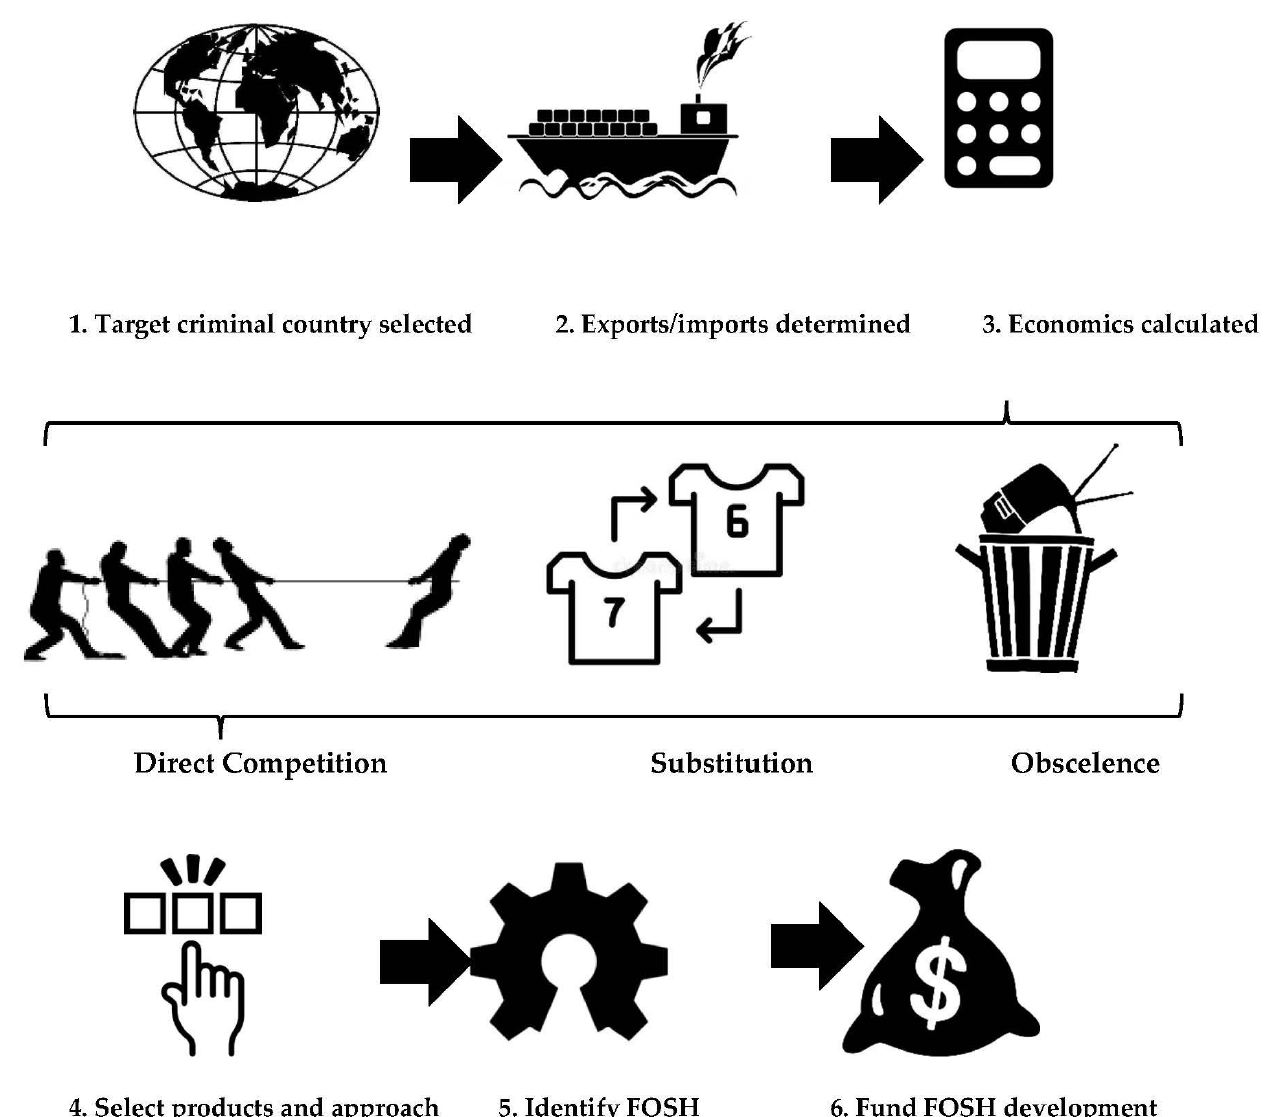
Figure 1. Flow diagram of method to determine strategic investments in open hardware.